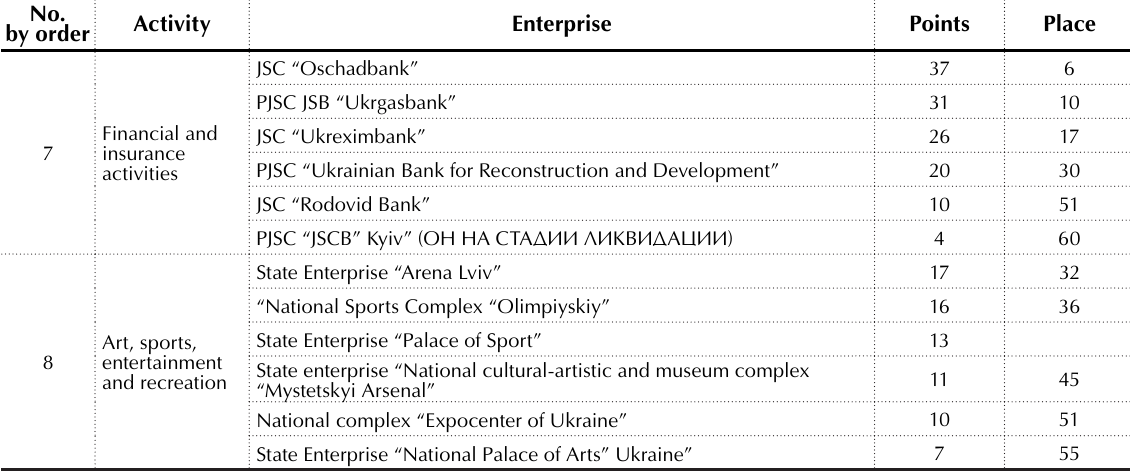
Table 1 (cont.). Index of transparency of Ukrainian state-owned companies by their sectoral affiliation No. by